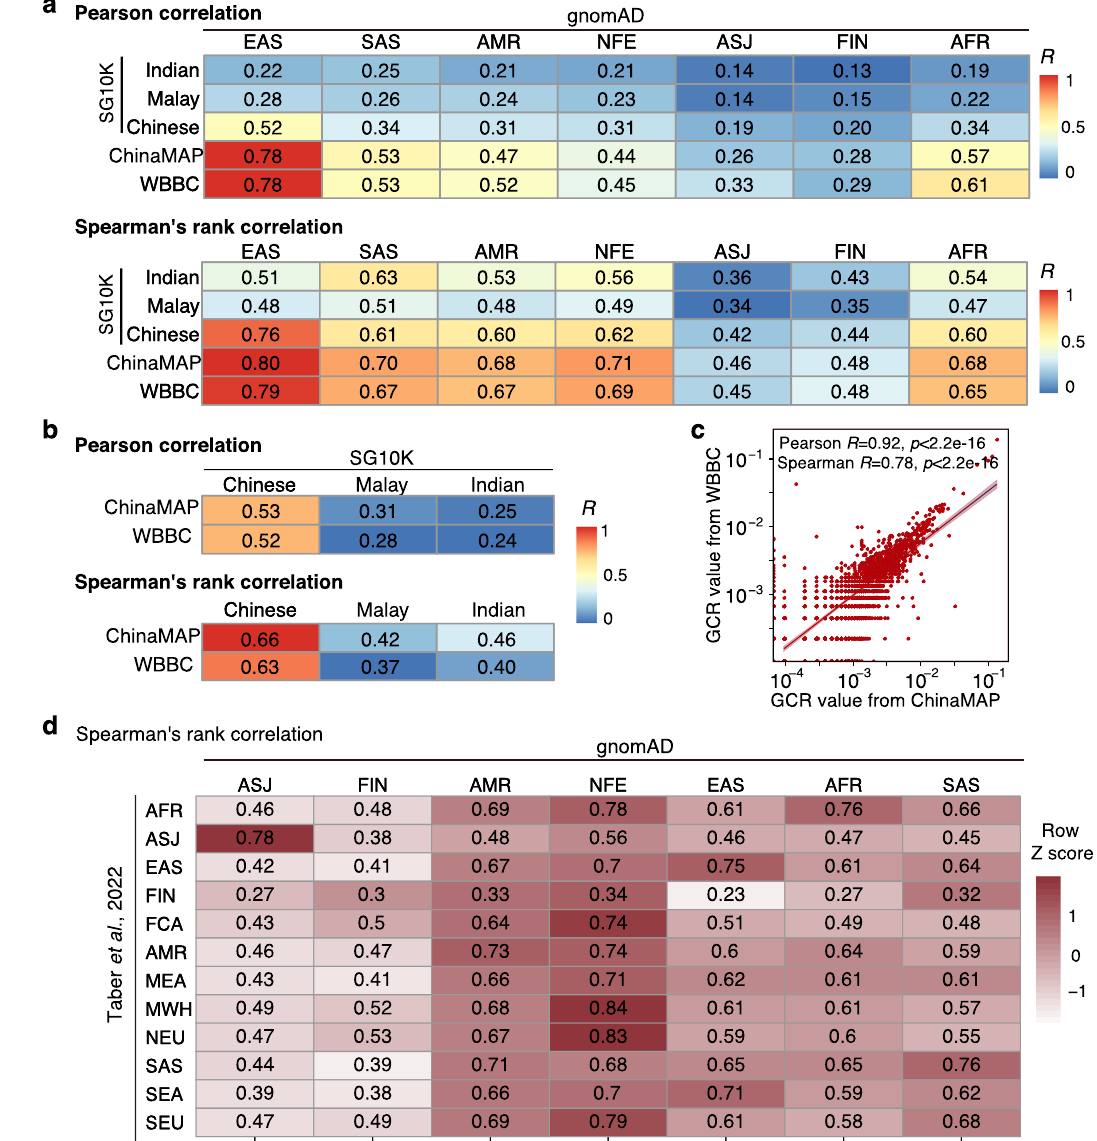
Fig. 4 Comparison of carrier frequencies among different cohorts. a Comparison between gnomAD populations and SG10K subpopulations, ChinaMAP Chinese or WBBC Chinese. Spearman ’ s rank correlation coef fi cient and Pearson correlation coef fi cient R scores are illustrated in each cell and color coded. Red indicates high correlation, while blue indicates low correlation. b Comparison between SG10K subpopulations and ChinaMAP Chinese or WBBC Chinese. c Comparison between ChinaMAP Chinese and WBBC Chinese. See also Supplementary Fig. 4 for comparison scatter plots and corresponding statistical P values. d Spearman ’ s correlation coef fi cients generated between our calculated carrier frequencies of gnomAD populations and actual ethnicity speci fi c carrier frequencies recorded from NGS based ECS (Taber et al . 2022 study, ref. 6 ). AFR African or African-American, ASJ Ashkenazi Jewish, MWH Mixed or Other White, FCA French Canadian or Cajun, EAS East Asian, FIN Finnish, AMR Hispanic (corresponding to the Latino/Admixed American population in gnomAD), MEA Middle Eastern, NEU Northern European, SAS South Asian, SEA Southeast Asian, SEU Southern European. The color stands for row-wise Z score scaled Spearman ’ s correlation coef fi cient. See also Supplementary Fig. 5 for Pearson correlation coef fi